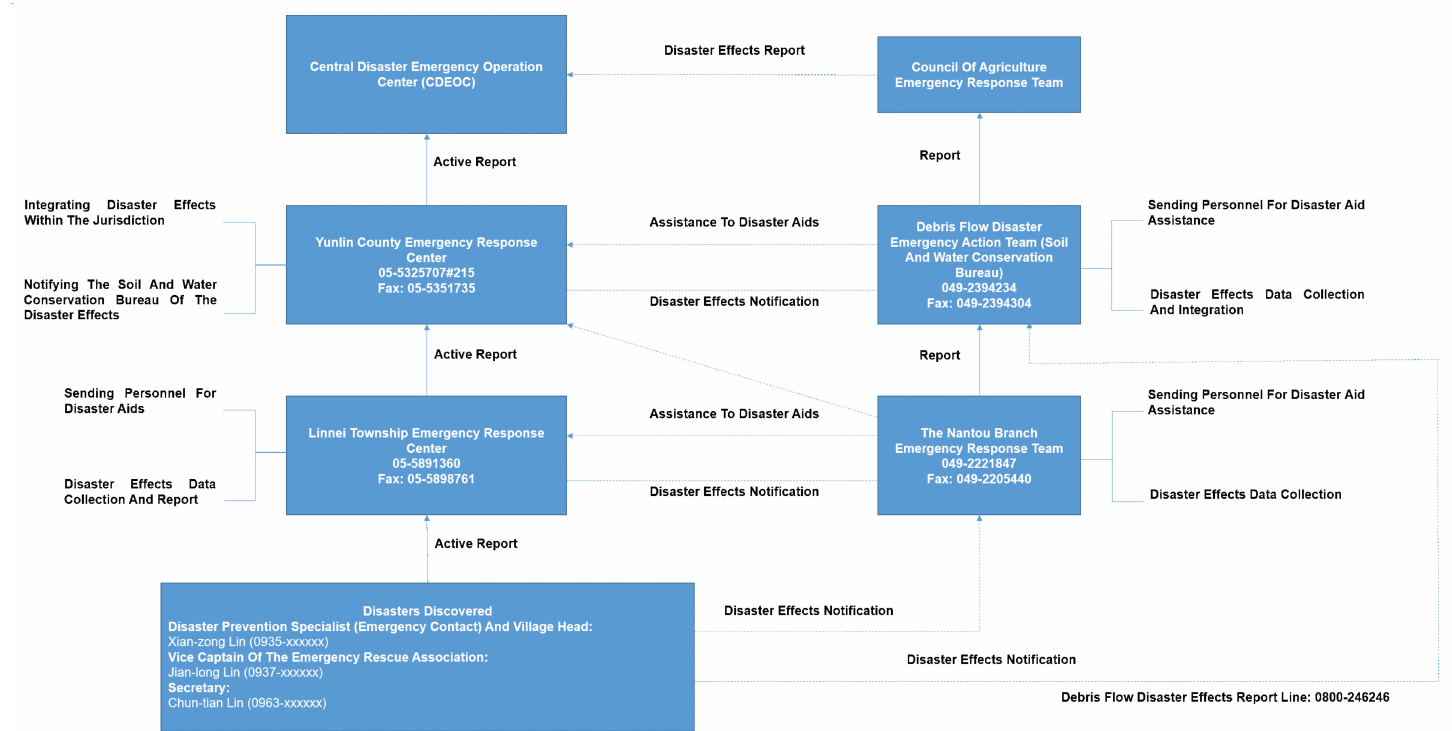
Figure 14. The reporting process for slope land collapse